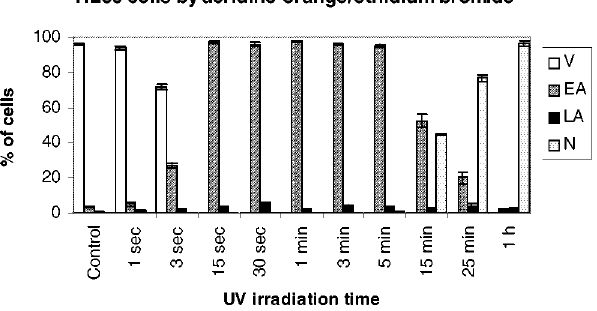
Fig. 4. Percentage of HL60 cells evaluated by acridine orange/ethidium bromide. V, viable cells; EA, early apoptotic cells; LA, late apoptotic cells; and N, necrotic cells. The results represent the mean of at least three independent experiments (cid:6) standard